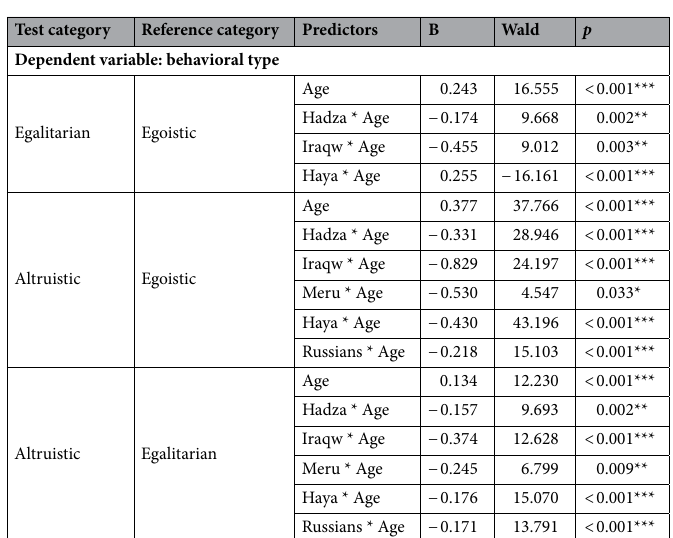
Table 6. Age effects on children’s behavior. Multinomial logistic regression model: parameter estimates. Behavioral types: Egoistic, Egalitarian, Altruistic, and Mixed. Only significant results for three first categories are presented. B—regression coefficient, Wald—test statistics, p —statistical significance (* p < 0.05, ** p < 0.01, *** p < 0.001). Full model is available in Supplementary Table 1.